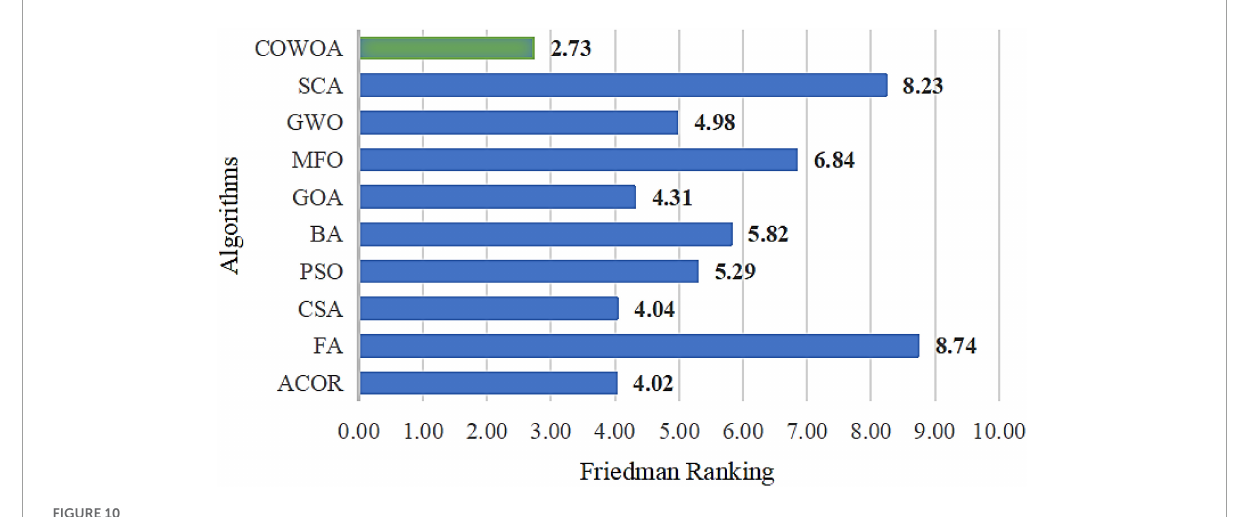
FIGURE10 Result of Friedman ranking between the COWOA and the well-known original algorithm.